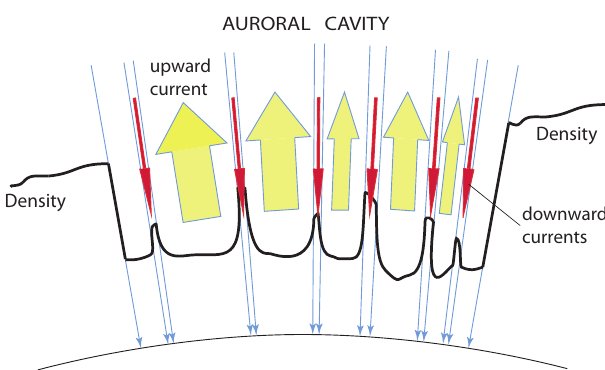
Fig. 6. Sketch of auroral cavity which is bounded by magnetic field lines (blue) and contains a large number of broad upward current regions (yellow upward arrows) and narrow downward current re- gions (red downward arrows) the latter having higher density than the former but less than outside the auroral cavity. Any radiation emitted in either of these regions will be trapped in the auroral cav- ity bouncing back and forth between its boundaries until escaping upward into free space. It should be clear from the figure that any radiation that has escaped from its small-scale source (e.g. electron hole as well as local distribution) will barely encounter any other favourable resonance at same frequency in the auroral cavity.